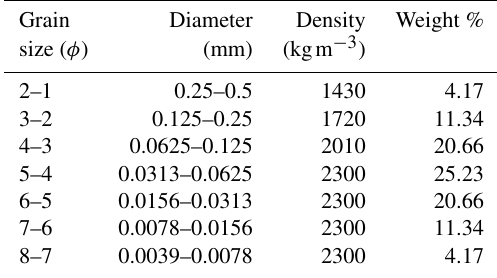
Table 3. Particle diameters and densities utilized in the sedimen- tation simulations. The particle densities as a function of the grain size listed here are extracted from Macedonio et al.